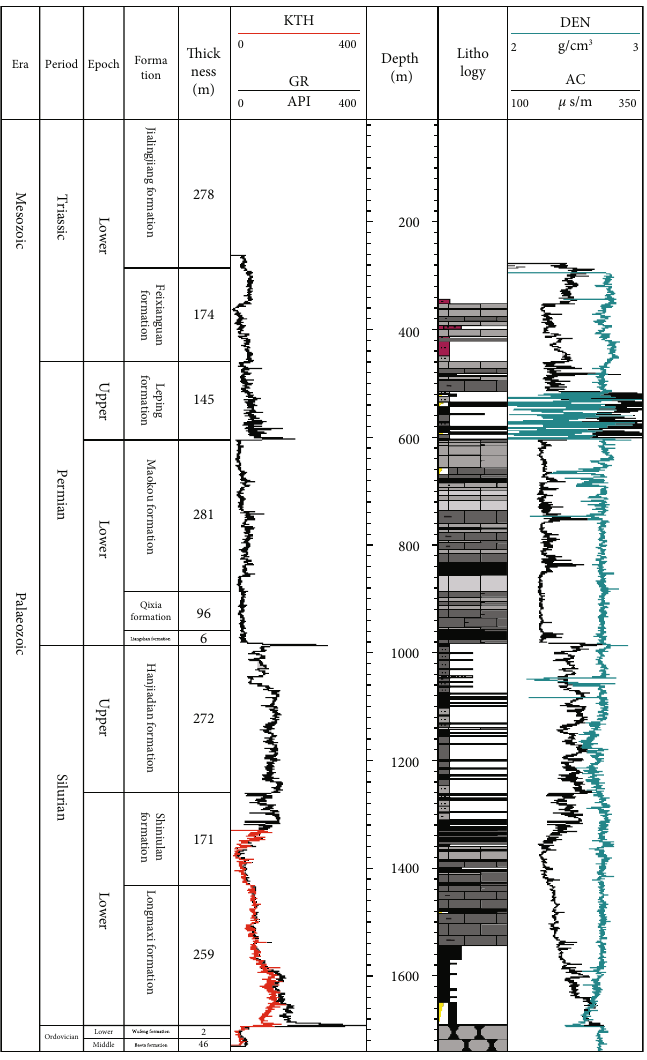
Figure 2: Lithofacies of a single well.